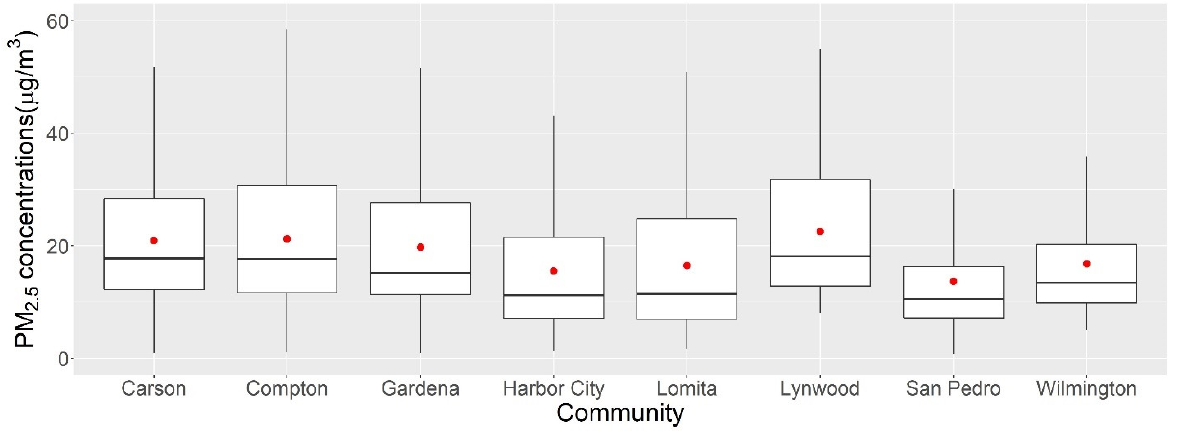
Figure 2. Boxplots of hourly PM 2.5 concentrations during summer and fall 2021 by community. The red dots indicate average concentrations. The boxes show the interquartile range (IQR). The upper whisker extends from the hinge to the largest value at most 1.5*IQR, while the lower whisker extends from the hinge to the smallest value at most 1.5*IQR.